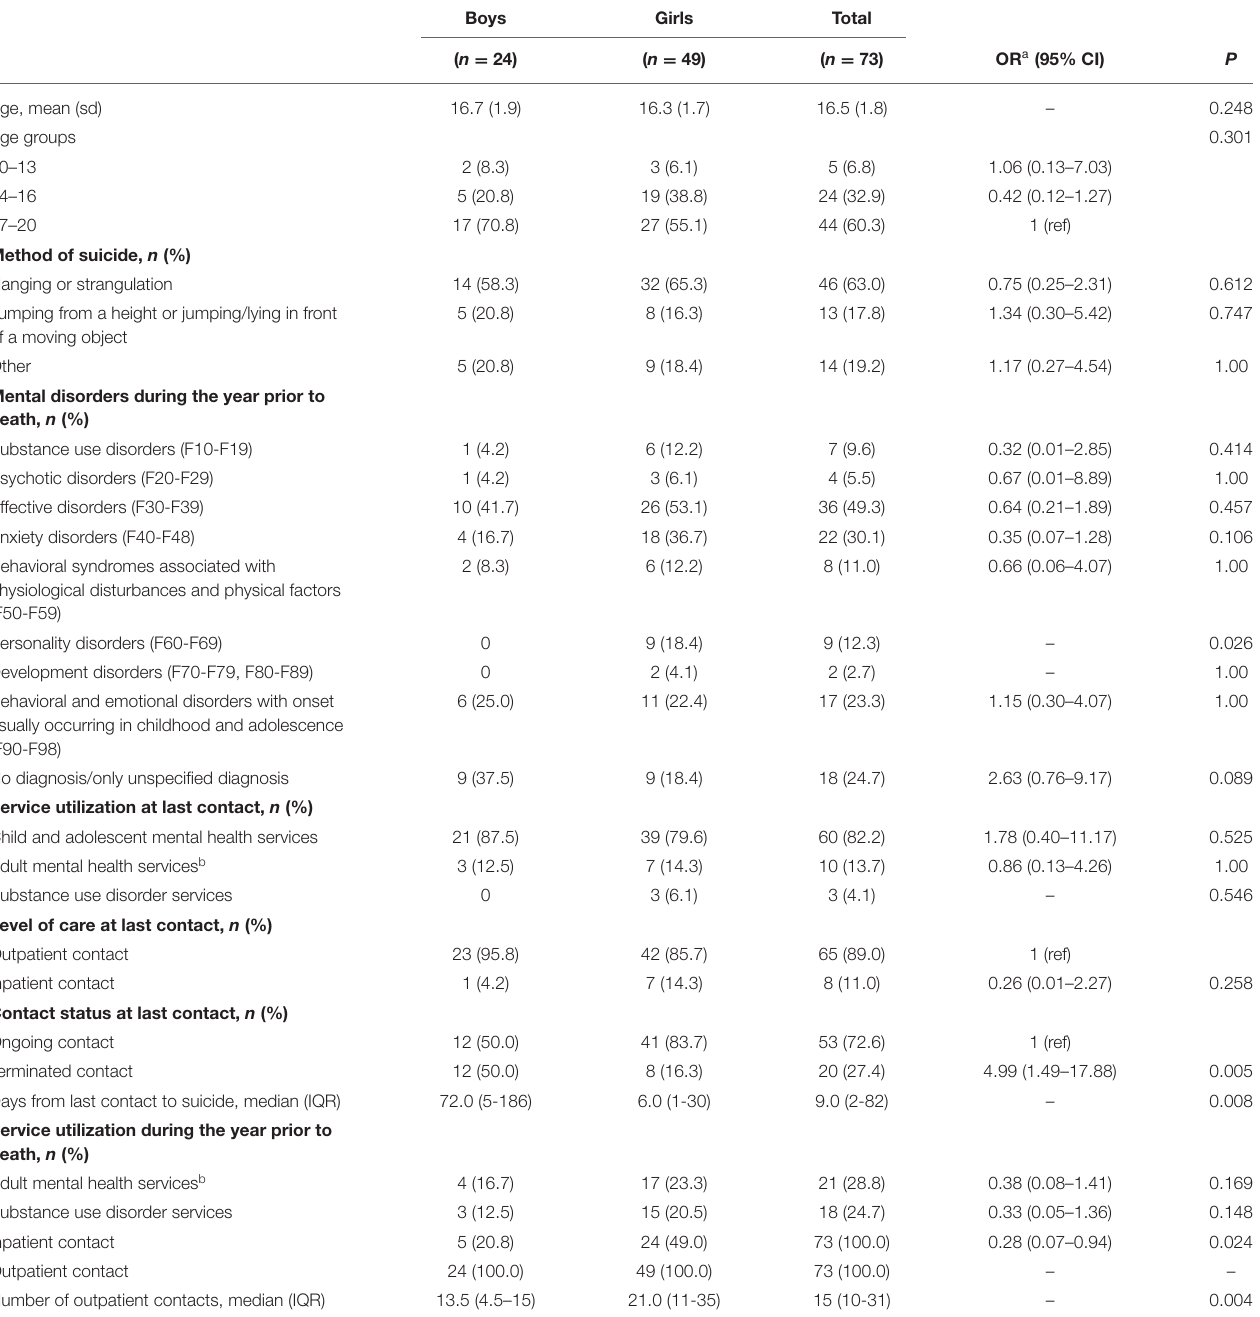
TABLE 2 | Description of all young people in contact with Child and Adolescent Mental Health Services (CAMHS) in the year prior to death by gender.